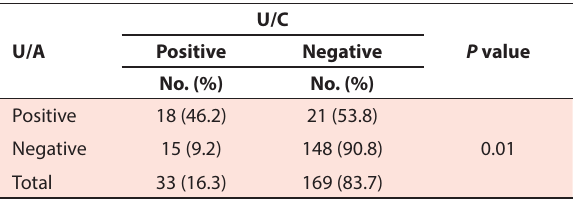
Table 2. Relationship between urine culture (U/C) and urine analysis (U/A)